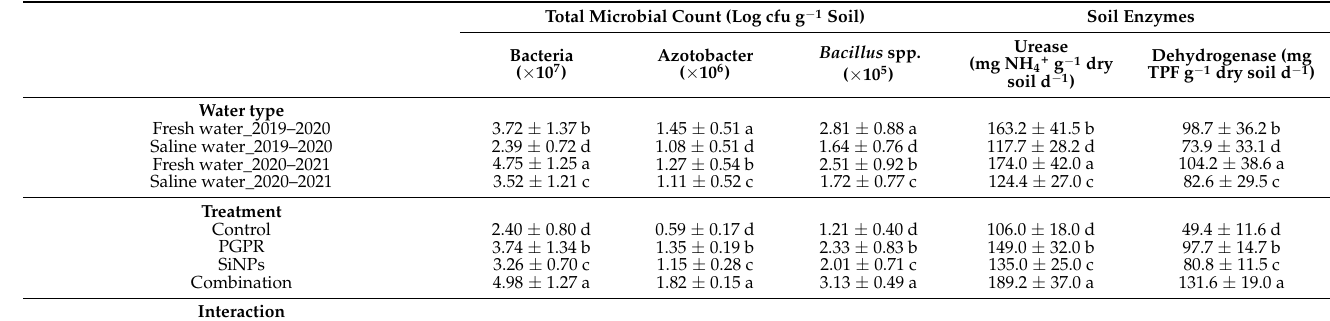
Table 2. Variation of the total count of some soil microbial populations and enzyme activity of salt-affected soil cultivated with barley ( Hordum vulgare L., cv. Giza 132), which was treated with plant growth-promoting rhizobacteria (PGPR; Azotobacter chroococcum SARS 10 and Pseudomonas koreensis MG209738), silica nanoparticles (SiNPs), and their combination to alleviate the detrimental impacts of saline irrigation water during two consecutive